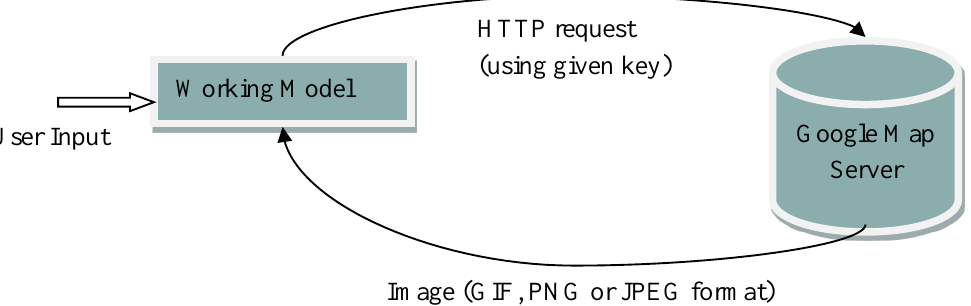
Figure 1. Process of obtaining image from Google server